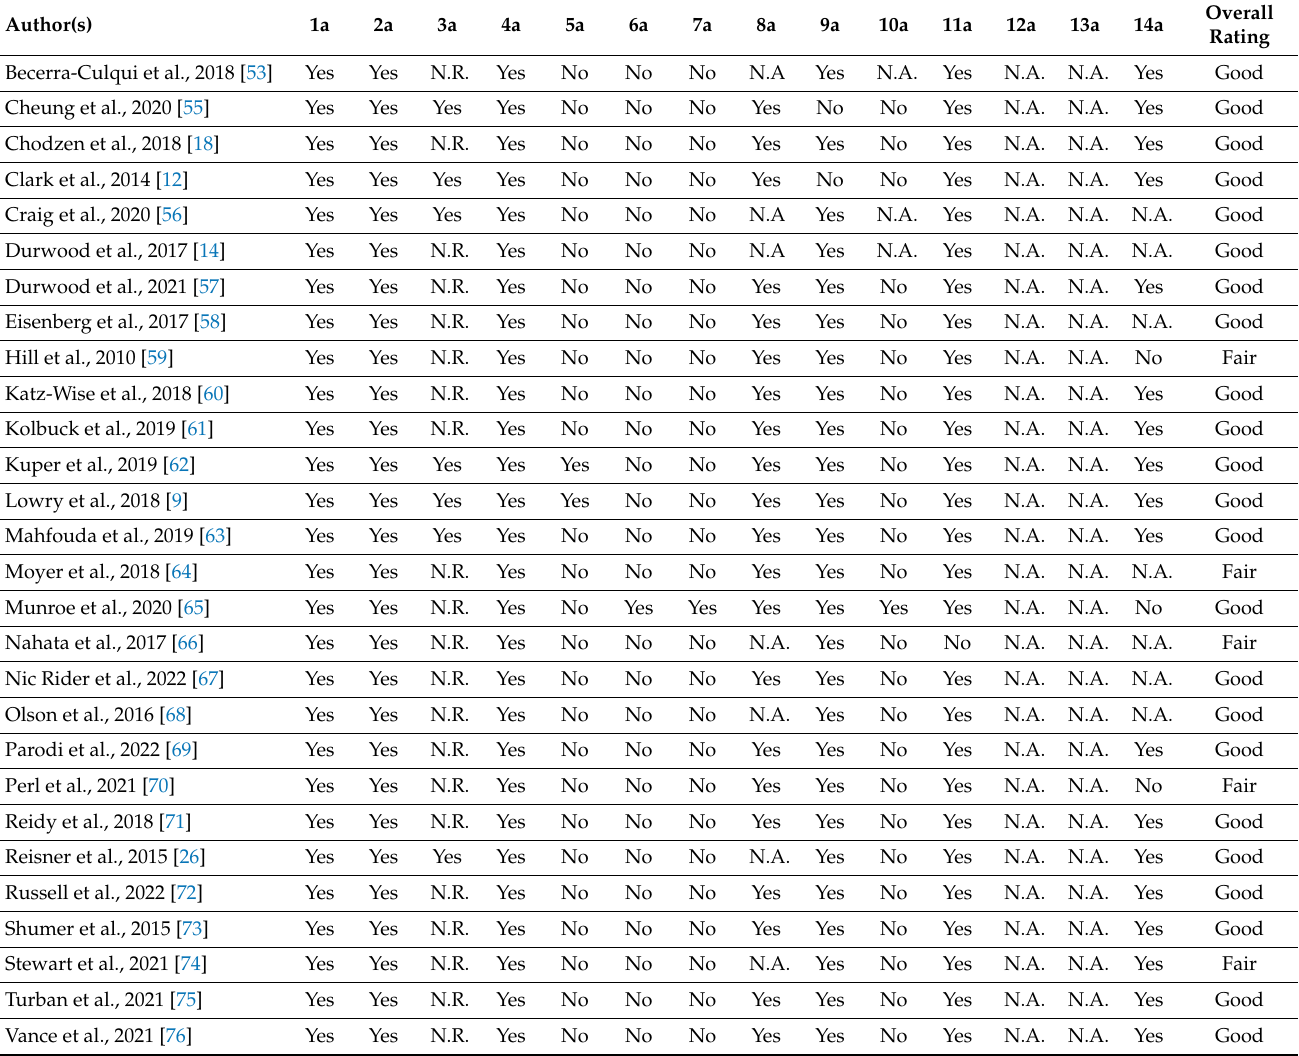
Table 2. Quality ratings of selected